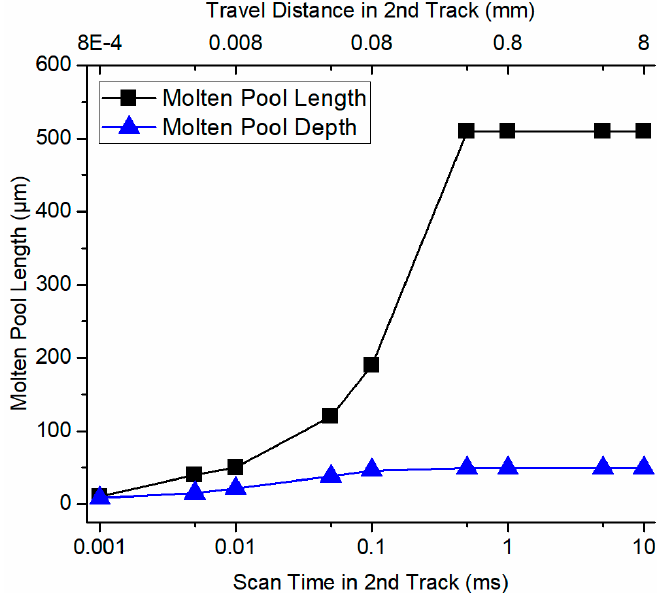
Figure 6. The growth and stabilization of predicted molten pool in the second track of bidirectional scans using the determined absorption of 40% in terms of molten pool length and molten pool depth.